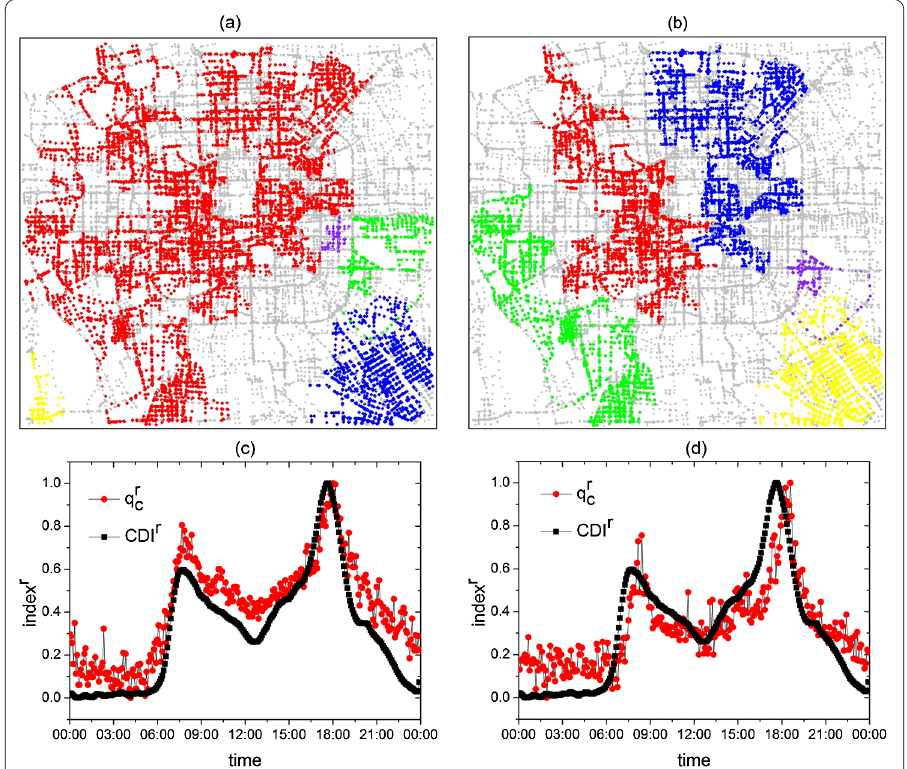
Figure 2 Similar trends of different indices. Traffic networks during the evening peak (at 18:36 pm on Oct. 24th) for q value: (a) just below q c ( q = 0.5) and (b) equals to q c ( q = 0.51). For clarity, only the largest five clusters are plotted, which are marked in red (largest cluster), blue (second-largest cluster), green (third-largest cluster), yellow (fourth-largest cluster) and purple (fifth-largest cluster). Here the clusters are strongly connected components, considering road direction. (c) Different indices as a function of time in Beijing on Oct. 29th, Thursday. (d) Different indices as a function of time in Shenzhen on Oct. 29th,